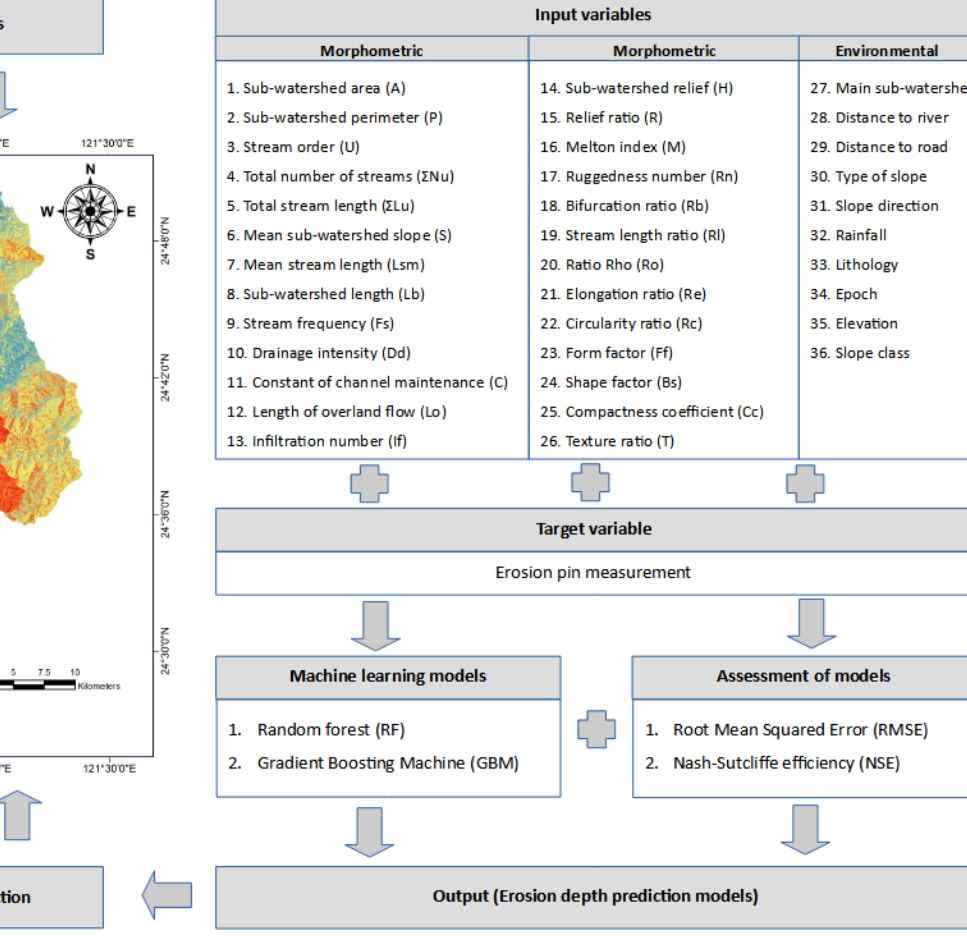
Figure 4. Research flowchart of this study.